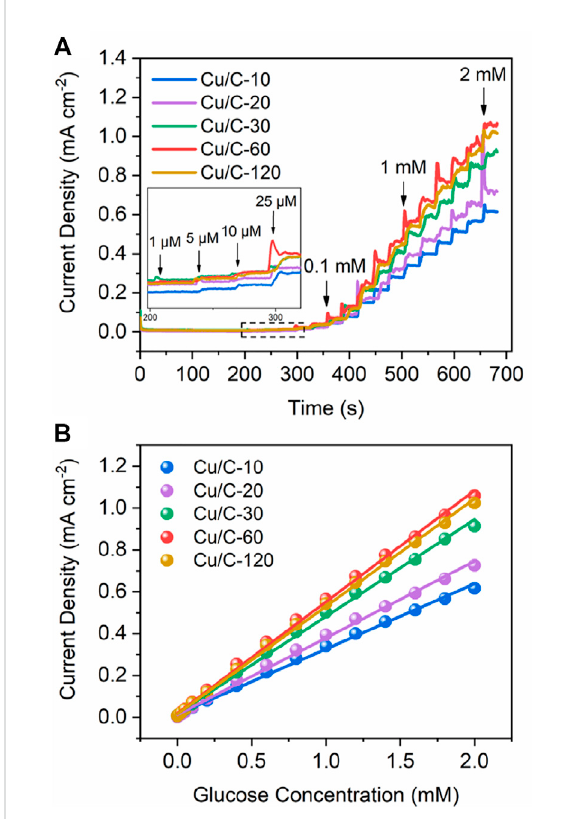
FIGURE 1 Current densities as functions of (A) time and (B) glucose concentration. The experiments are fi rstly conducted without glucose in the reaction solution from 0 to 210 s. At 210, 240, 270, 300, 330, 360, and 390s, 0.001, 0.005, 0.01, 0.025, 0.05, 0.10, and 0.20 mM glucose are added into the reaction solution separately.After390 s,0.20 mMglucoseisaddedintothereaction solution for every 30 s. The glucose concentration shown in the fi